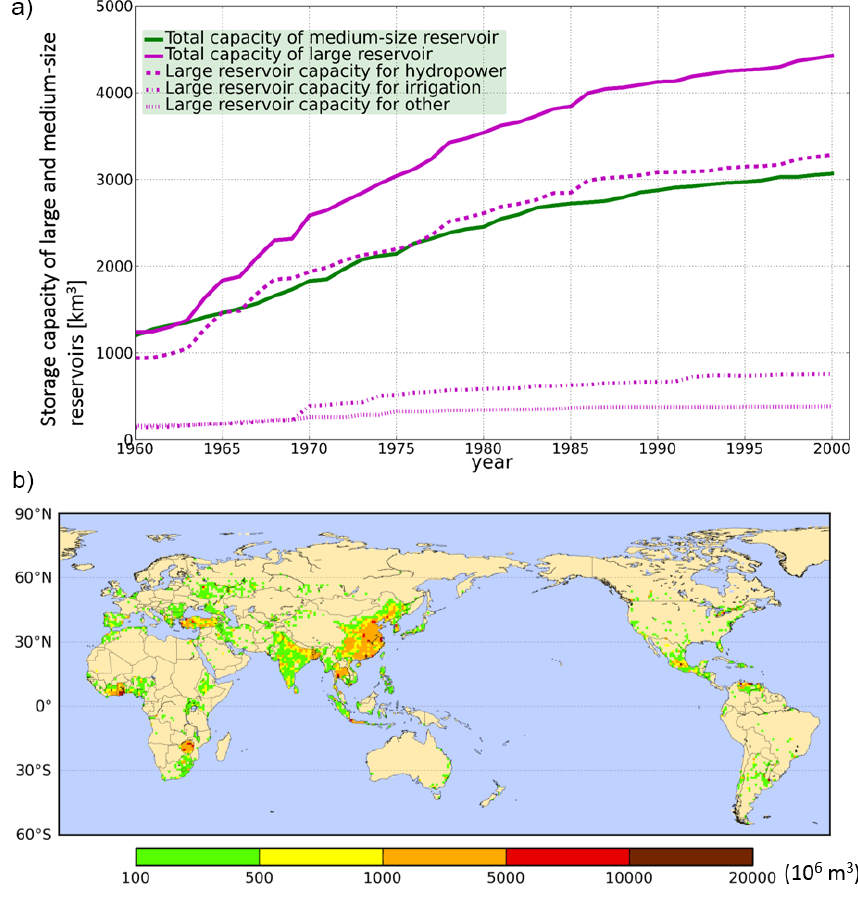
Figure 3. Total cumulative storage capacity of large and medium-size reservoirs (km 3 ) and the cumulative storage capacity of large reservoirs for hydropower, irrigation and other uses during the period 1960–2000 (a) , and a distribution map showing the difference in storage capacity (10 6 m 3 ) of medium-size reservoirs for the years 2000–1960 (b) . In (a) , the magenta short-dashed line shows the storage capacity of large reservoirs for irrigation. If a reservoir has multiple functions, the most important function was